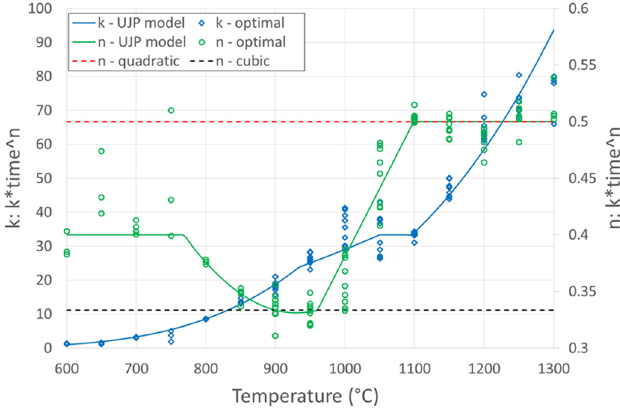
Fig. 3. Optimal coef fi cients k and n for each temperatures and maximal consider exposure time and the new oxidation kinetics